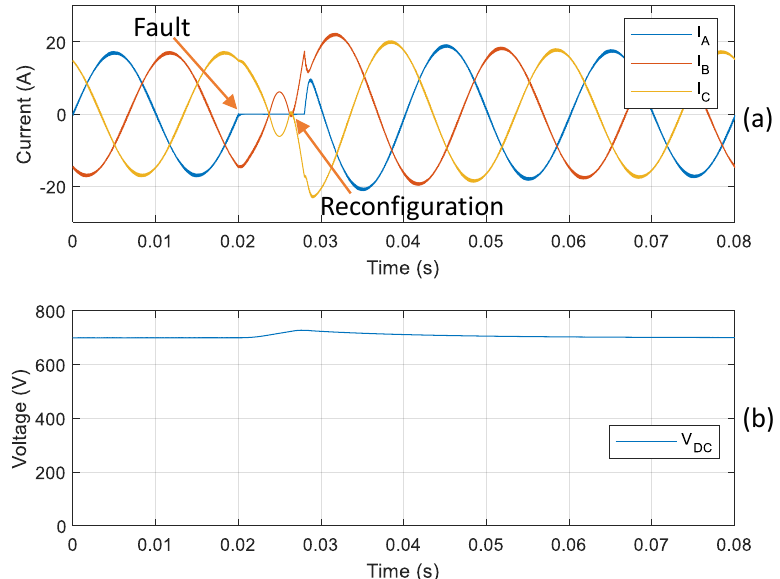
Figure 4. Simulation of an open-circuit fault on switch S AT . ( a ) grid currents. ( b ) DC-link voltage.